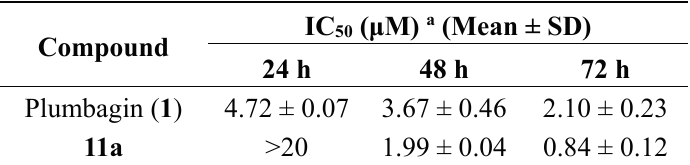
Table 2. Cytotoxicity of plumbagin ( 1 ) and 11a on HT-29 for 24 h, 48 h, and 72